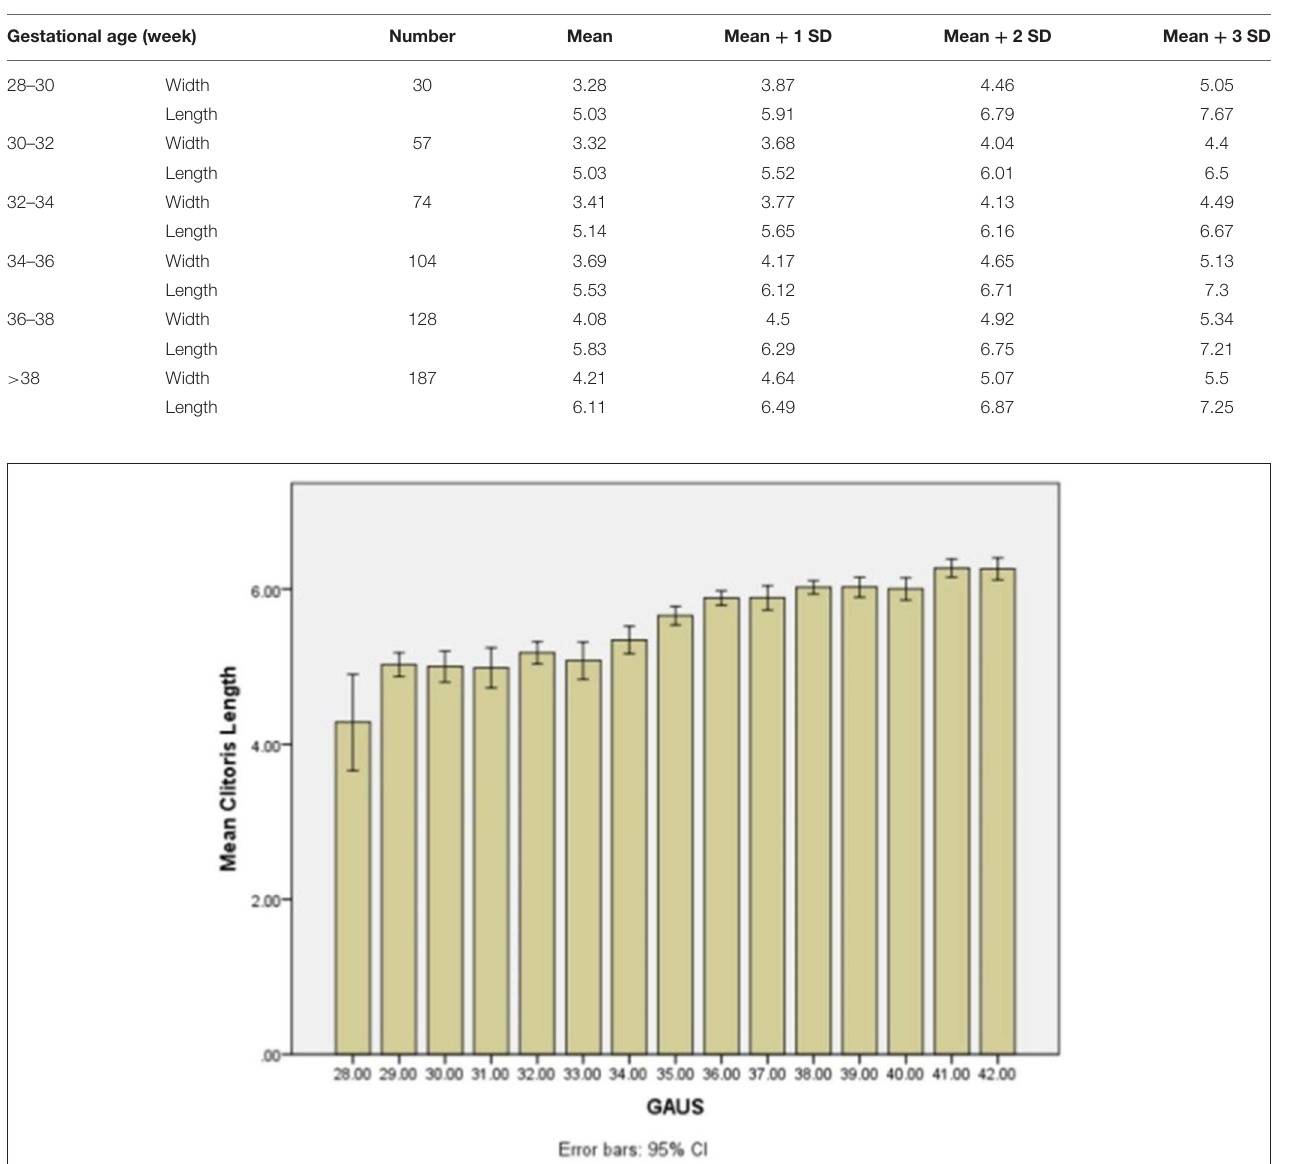
FIGURE 1 | Mean and SD of clitoral length based on different gestational ages of neonates.